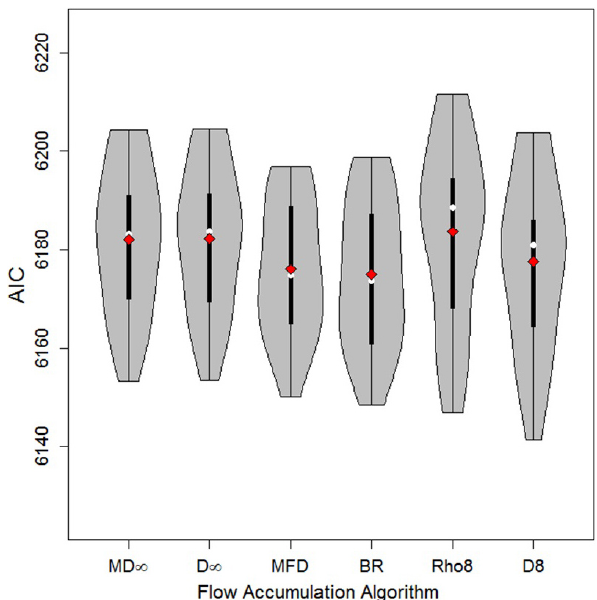
Figure 8. AIC values vs. flow accumulation algorithm for the USGS data set.